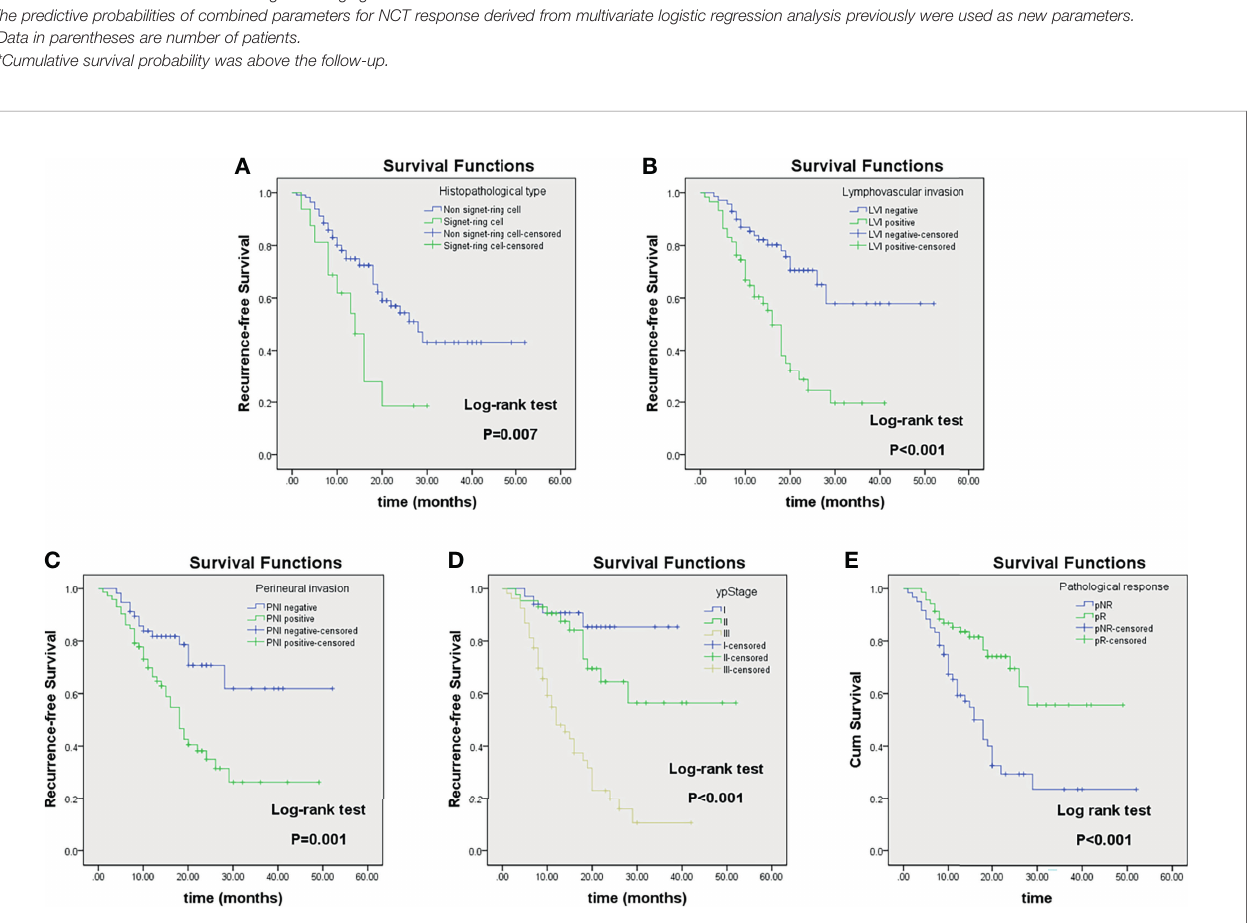
FIGURE 6 | Kaplan – Meier analyses of recurrence-free survival (RFS) in locally advanced gastric cancer (LAGC) patients (n = 129) strati fi ed by category: histopathological type (A) , lymphovascular invasion (B) , perineural invasion (C) , ypStage (D) , and pathological response (E)